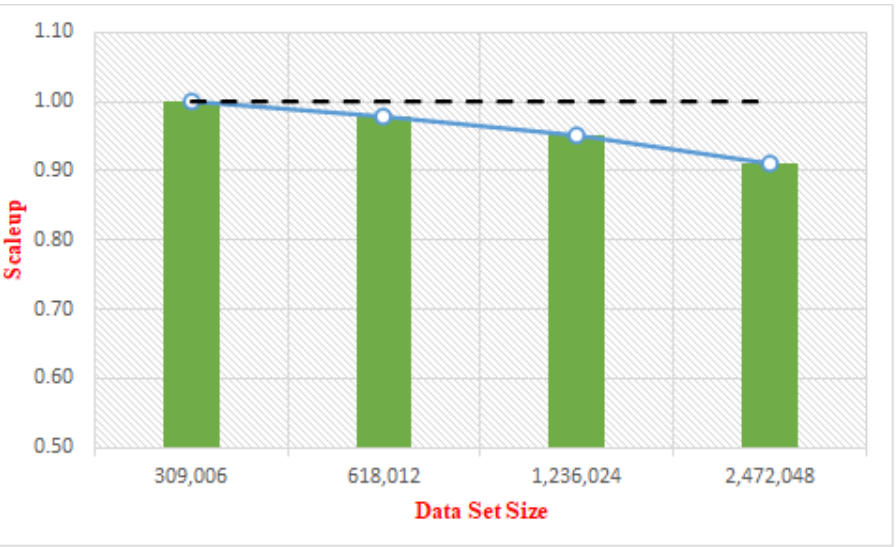
Figure 6. Scaleup of ABCCS; the dashed black line is an optimal